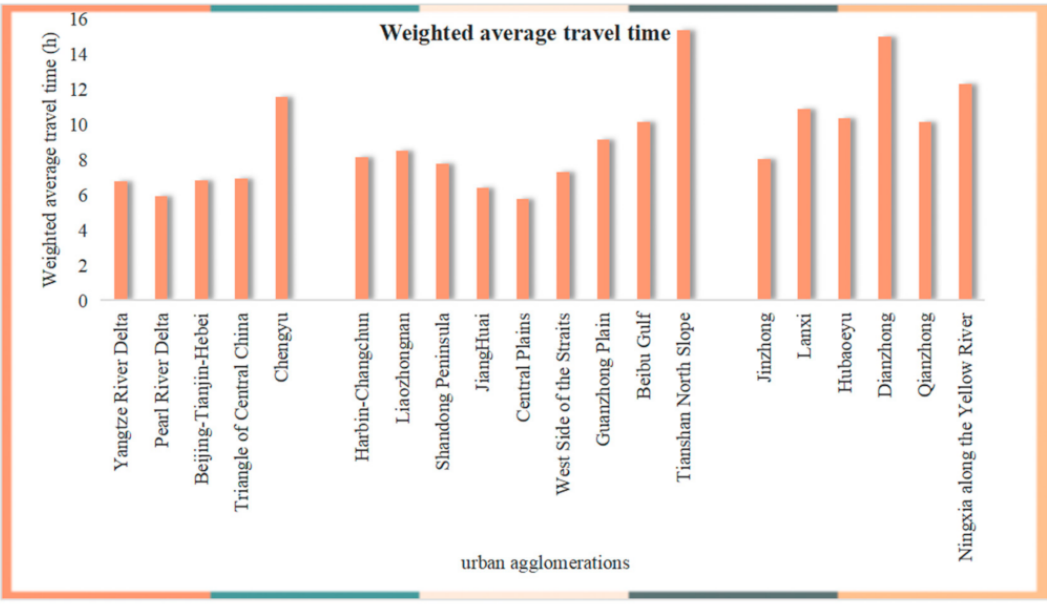
Figure 9. Weighted average travel time in 20 urban agglomerations.